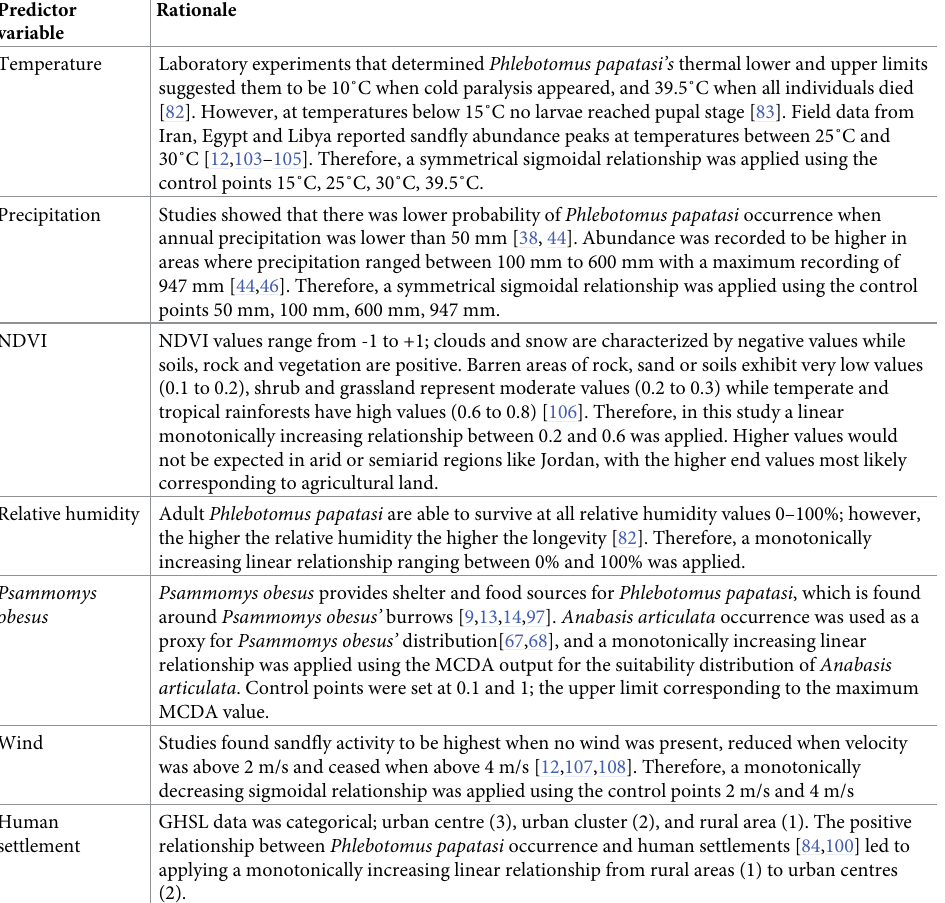
Table 4. Predictor variables’ fuzzy membership functions. Inclusion of the associated rationale used to convert the predictor variables into fuzzy sets for inclusion in the multicriteria decision analysis